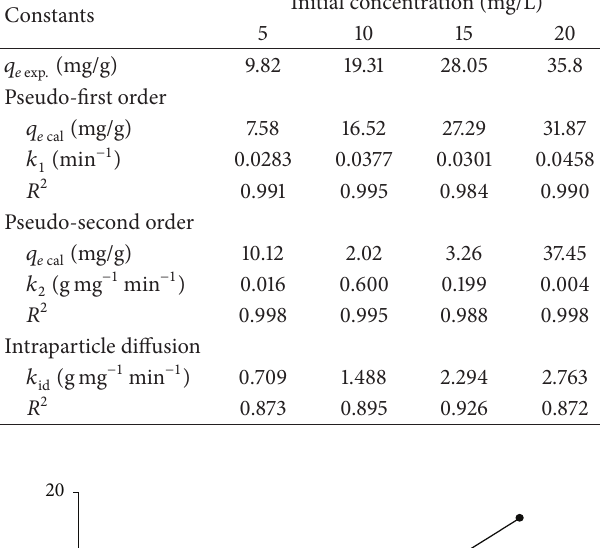
Table 2: A pseudo-first-order, pseudo-second-order, and intra- particle diffusion model parameter for adsorption of lead ion onto CCRWSD.